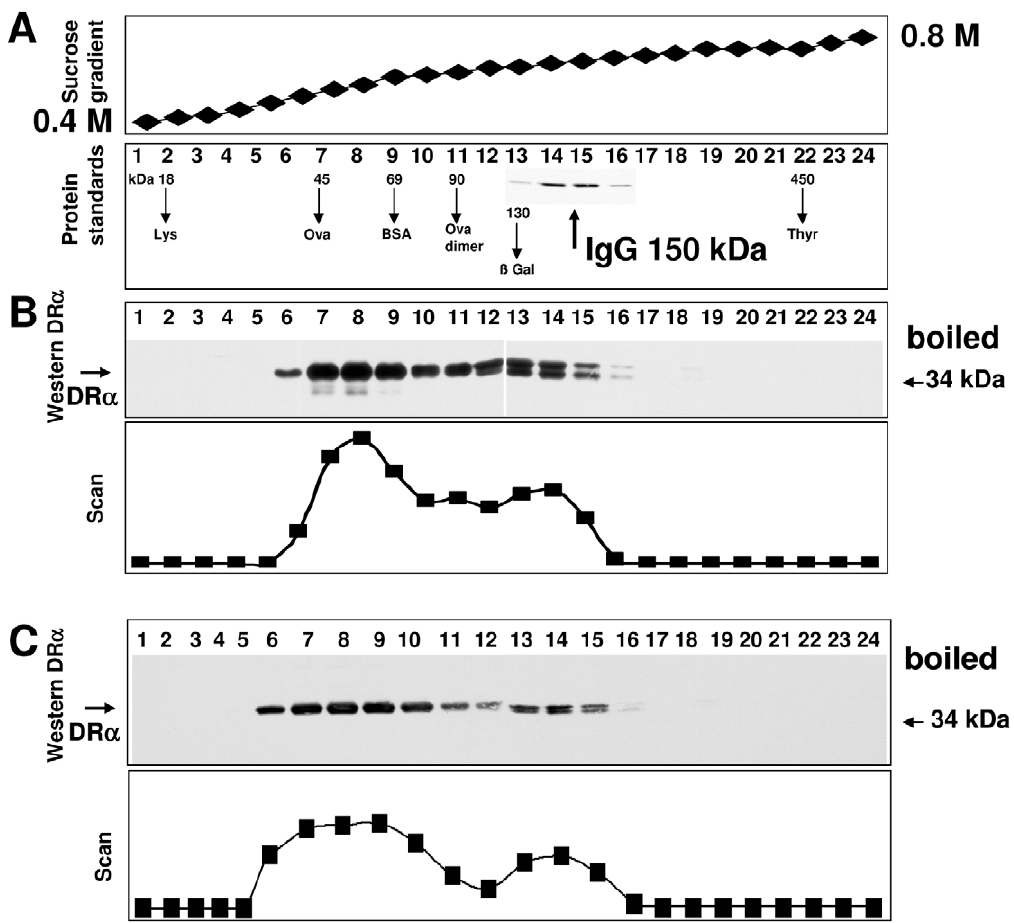
Figure 1. Separation of cell extracts on a sucrose gradient by ultra-centrifugation. Cell lysates were ultra-centrifugated on a 0.4 to 0.8 M sucrose gradient at 100 000 g for 50 h. A) The sucrose concentrations of the fractions were determined after ultracentrifugation by a refractometer (upper panel). In a parallel tube, molecular weight standards were separated (lower panel). The SDS-PAGE separated protein standards were stained with Coomassie blue. The peak positions of the separated molecular weight markers are indicated by arrows. IgG bands (insert) are shown in fractions 14 and 15. B) Twenty four samples, obtained from the fractions of the sucrose gradient of Raji cell lysates were boiled in SDS sample buffer and analysed by SDS-PAGE and subsequent western blotting with monoclonal antibody TAL-1B5 against DR a (upper panel). C) Cell lysates from monocyte-derived human dendritic cells separated by the sucrose gradient were western blotted for DR a . The positions of DR a and of a protein standard (34 kDa) are indicated by arrows. The lower panels of B and C show densitometric scans of the western blots.